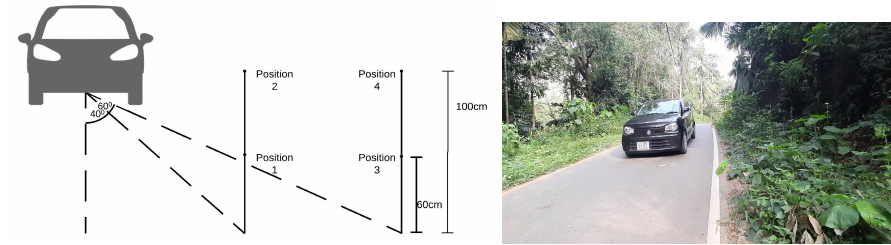
Figure 11. Camera positions ( left ) and sample deployed image ( right ).